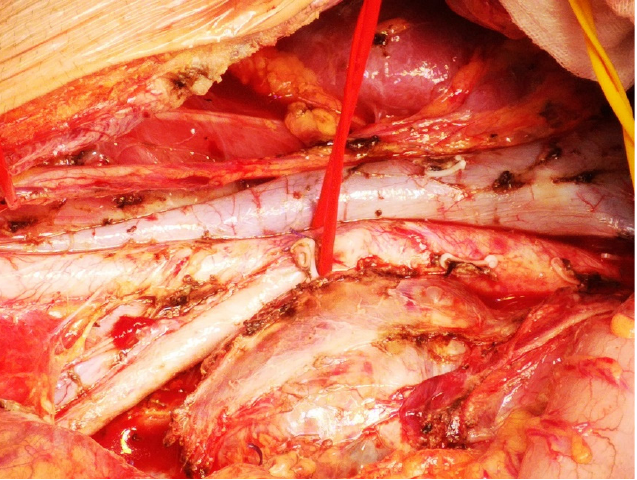
Figure 4. Bilateral RPLND template with inferior mesenteric artery dissection.